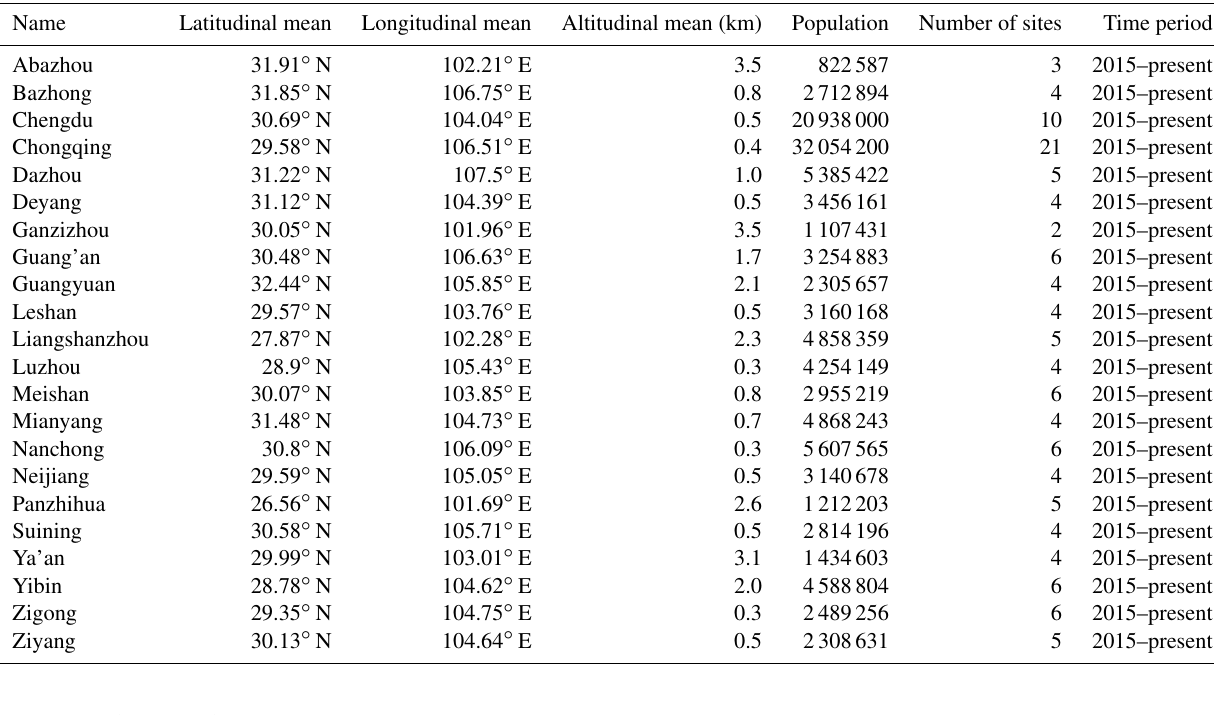
Table 1. Measurement sites in the SCB city cluster. All sites are organized alphabetically. Population statistics are based on the seventh nationwide population census in 2020 provided by National Bureau of Statistics of